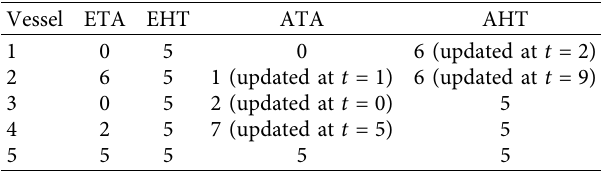
Figure 1: Example solution for Bulk-BAP with five vessels and three Table 1: Example of disruptive scenario.